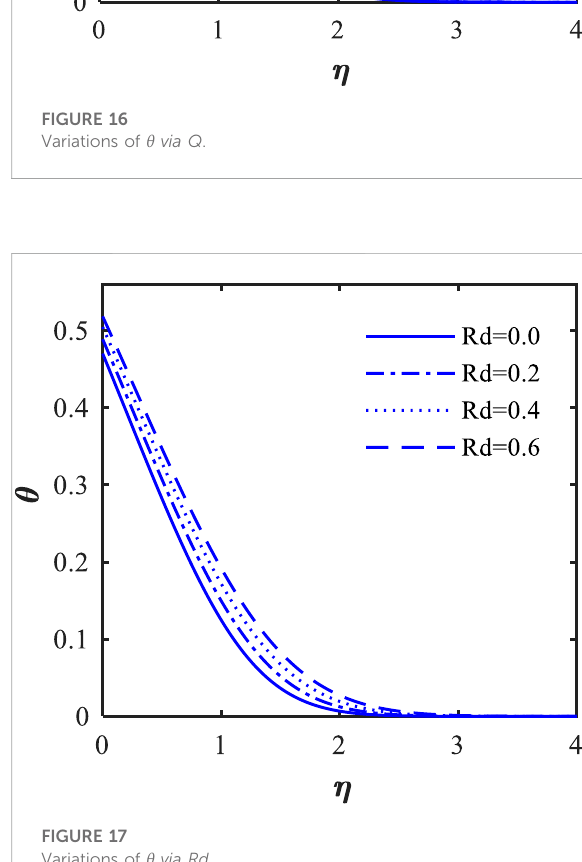
FIGURE 17 Variations of θ via Rd